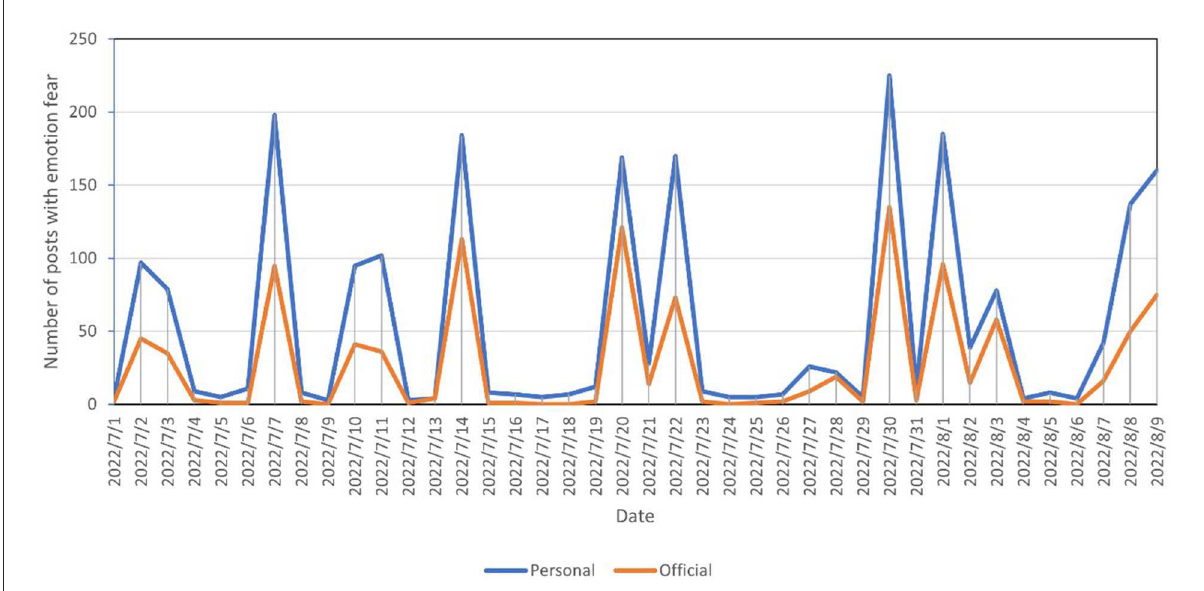
FIGURE4 Number of blogs with the emotion of fear posted by official and personal users.